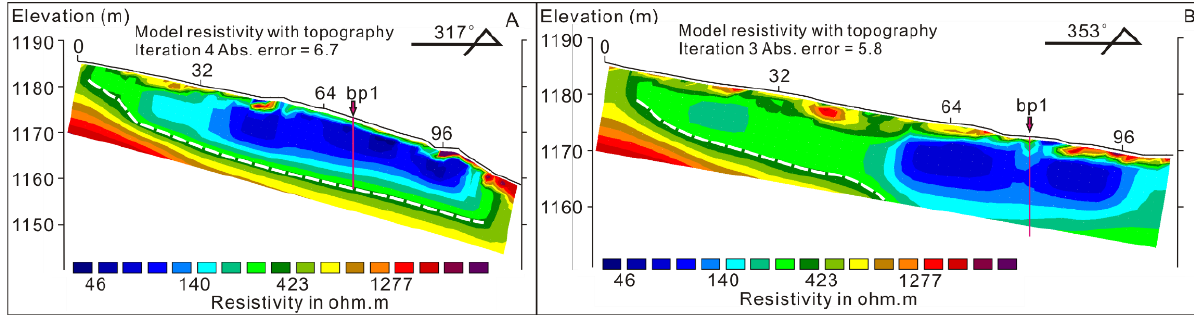
Figure 5. Resistivity results and interpretations. ( A ) Resistivity profile along L1. ( B ) Resistivity profile along with L2. The white dotted line is the dividing line between the debris fan and the underlying rock layer. L1, L2, and bp1 are shown in Figure 3.